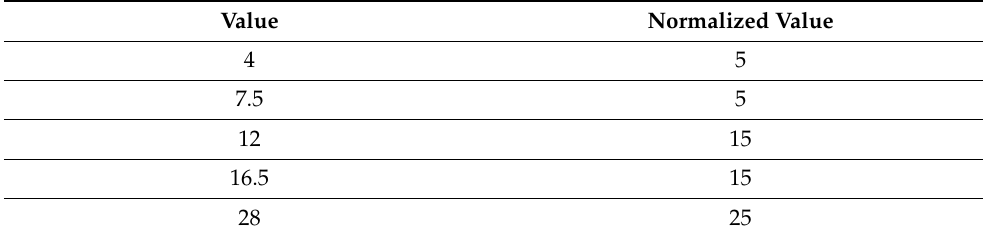
Table 3. Midpoint-Bin Normalization assuming bin with size